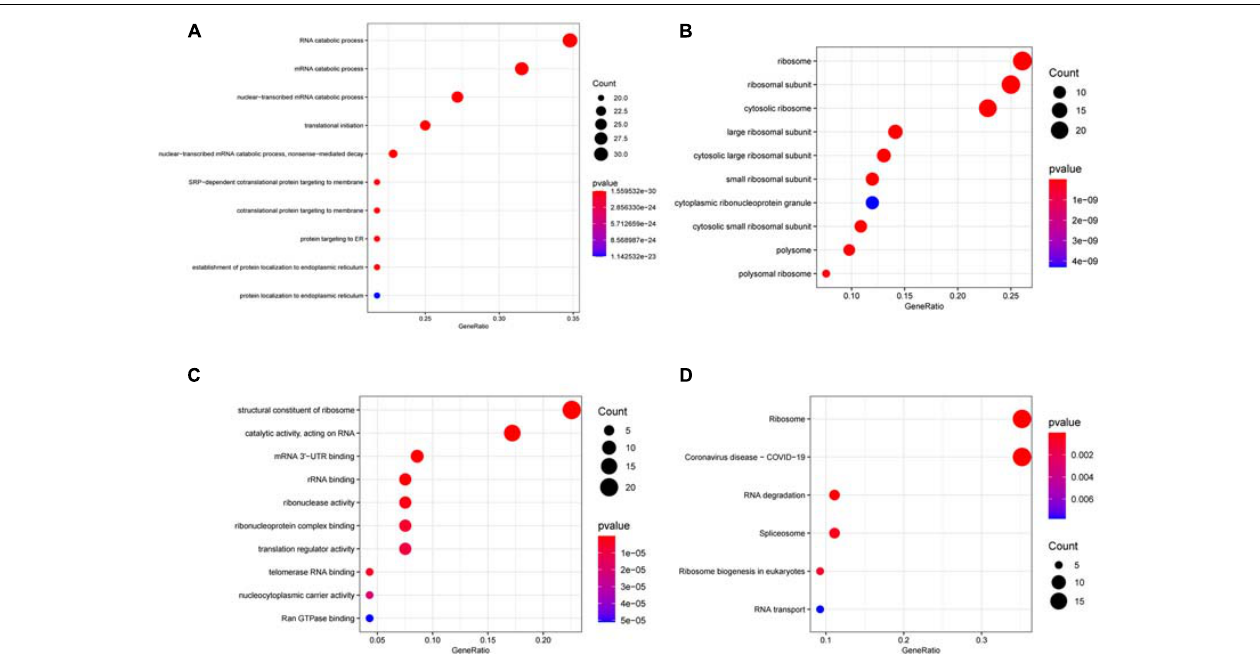
FIGURE 2 | Functional enrichment analysis of DEGs showed by bubble plots. (A–C) Three sub ontologies of GO enrichment analysis. (A) The biological process (BP) enrichment analysis. (B) The cellular component (CC) enrichment analysis. (C) The molecular function (MF) enrichment analysis. (D) The KEGG enrichment analysis.